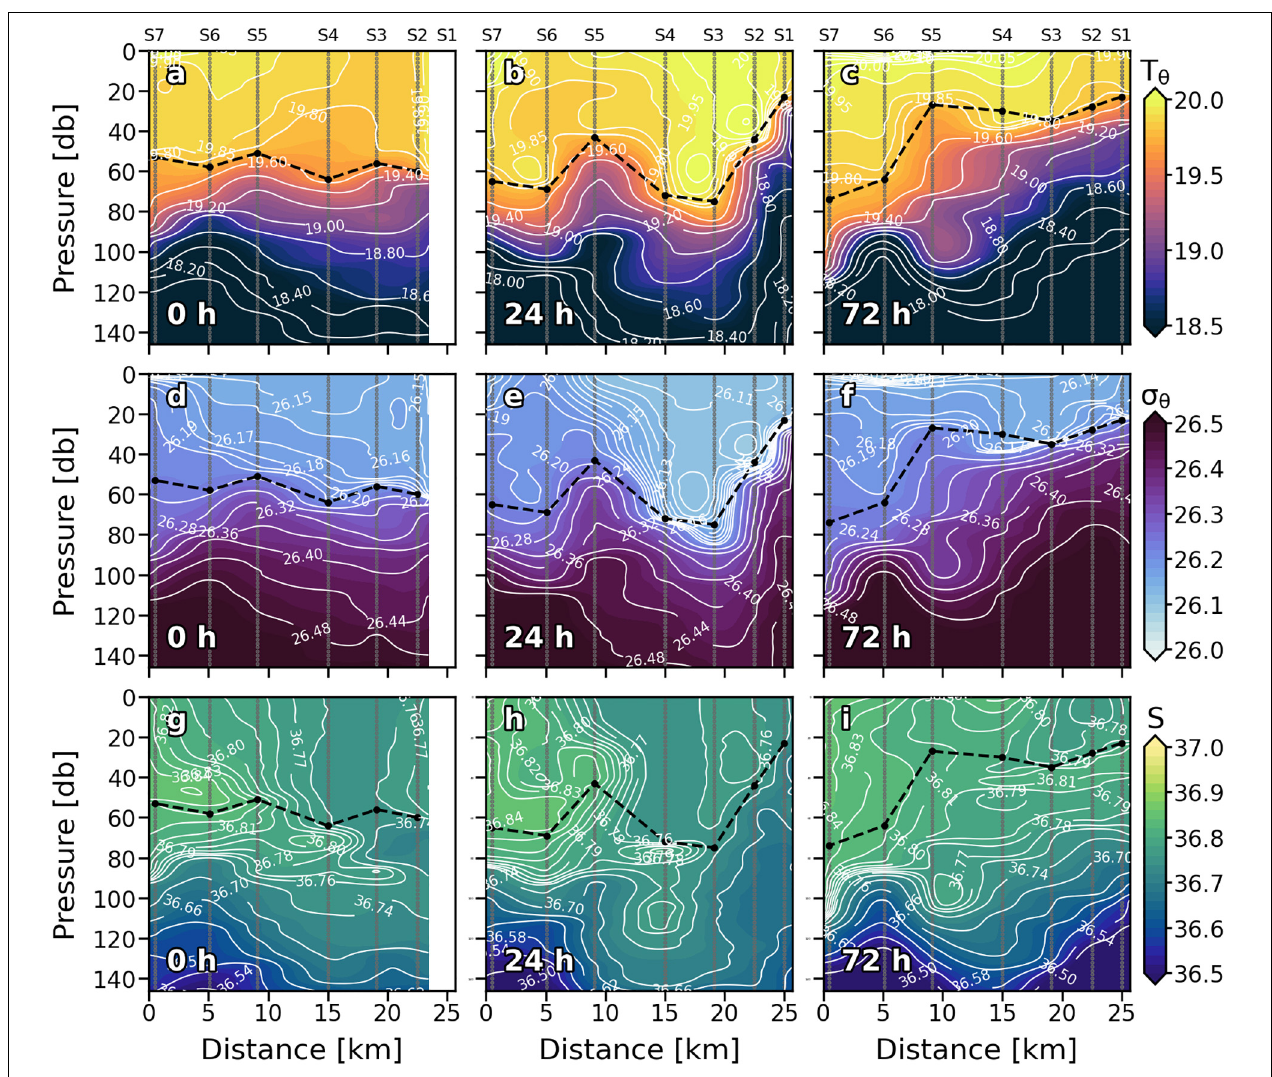
FIGURE 2 | Vertical sections of potential temperature (T q ) ( ◦ C) (a–c) , potential density ( σ q ) (kg · m − 3 ) (d–f) and salinity (S) (g–i) for every sampling day. Stations are indicated in the upper part of the plot. Isopycnal field is superimposed as solid white lines. Dashed black line indicates the mixed layer depth. Sampling depths are represented by gray